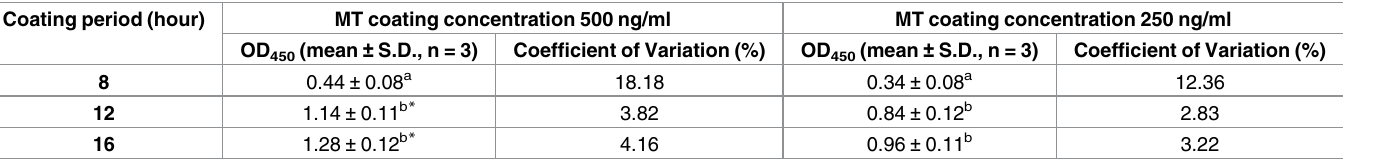
Table 4. The effectsof different coating periods on OD 450